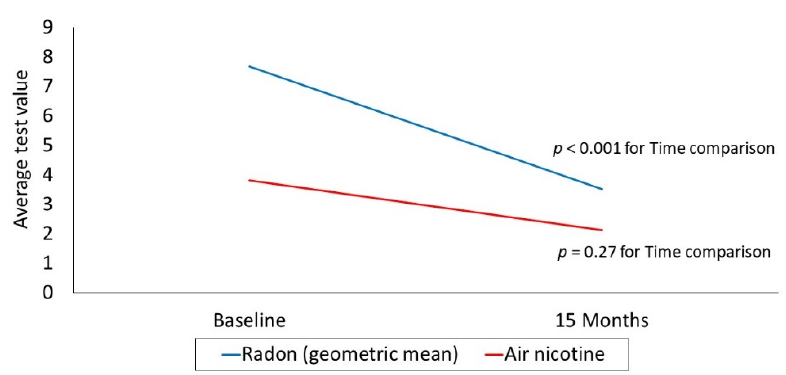
Figure 2. Radon and air nicotine at baseline and 15 months.